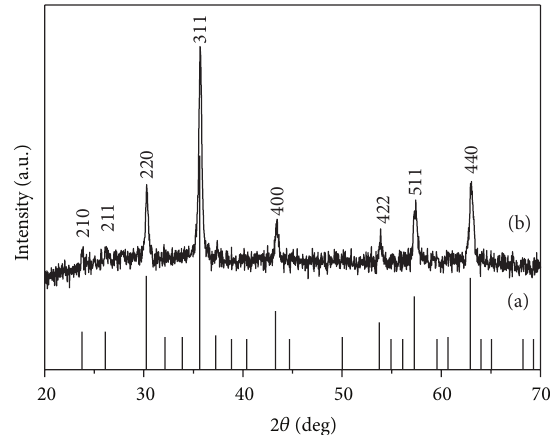
Figure 1: XRD patterns of the simulated 𝛾 -Fe 2 O 3 (a) and the prepared 𝛾 -Fe 2 O 3